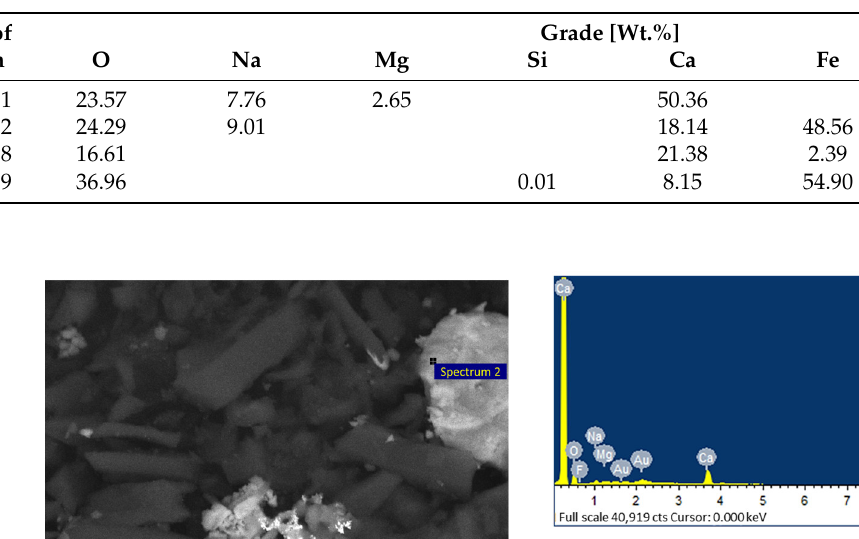
Table 12. Elemental composition of the spectra for the samples shown in Figures 18 and 19.